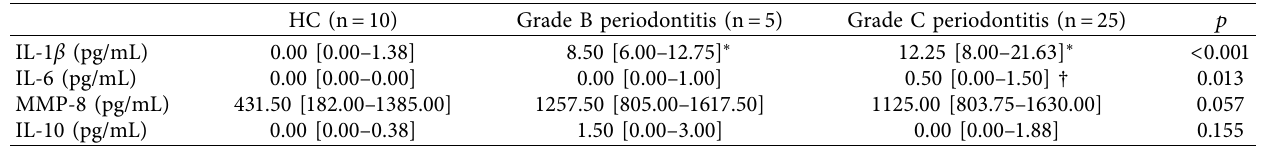
Table 4: Salivary mediator